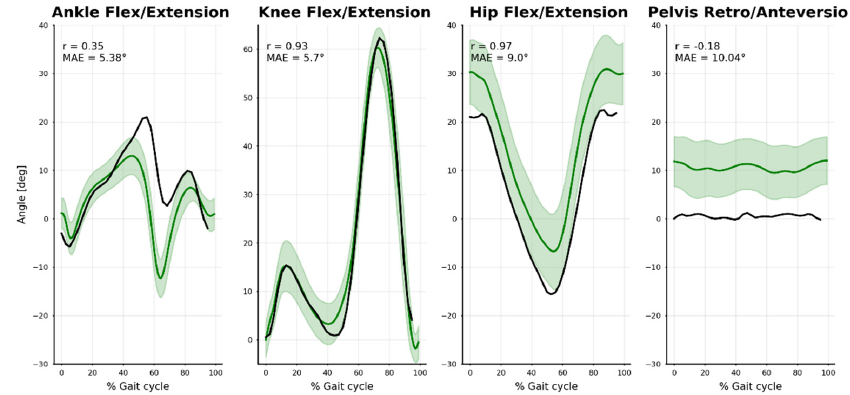
Figure 8. Comparison between our markerless results (black line: mean stride-to-stride results for our subject) and the normative marker-based database (green line and area: mean and standard deviation across 14 young, healthy, male subjects). Mean absolute error (MAE) and Pearson correlation coefficient (r) are represented.